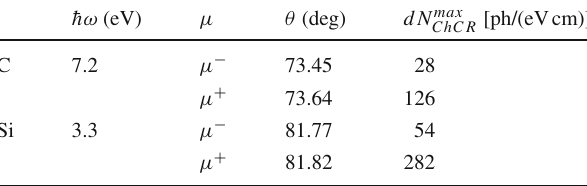
Table1 MaximumnumberofChCRphotons(hittingthephotondetec- tor) emitted by 10 GeV muons planar channeled in both C (110) and Si (110) crystals and related polar angles